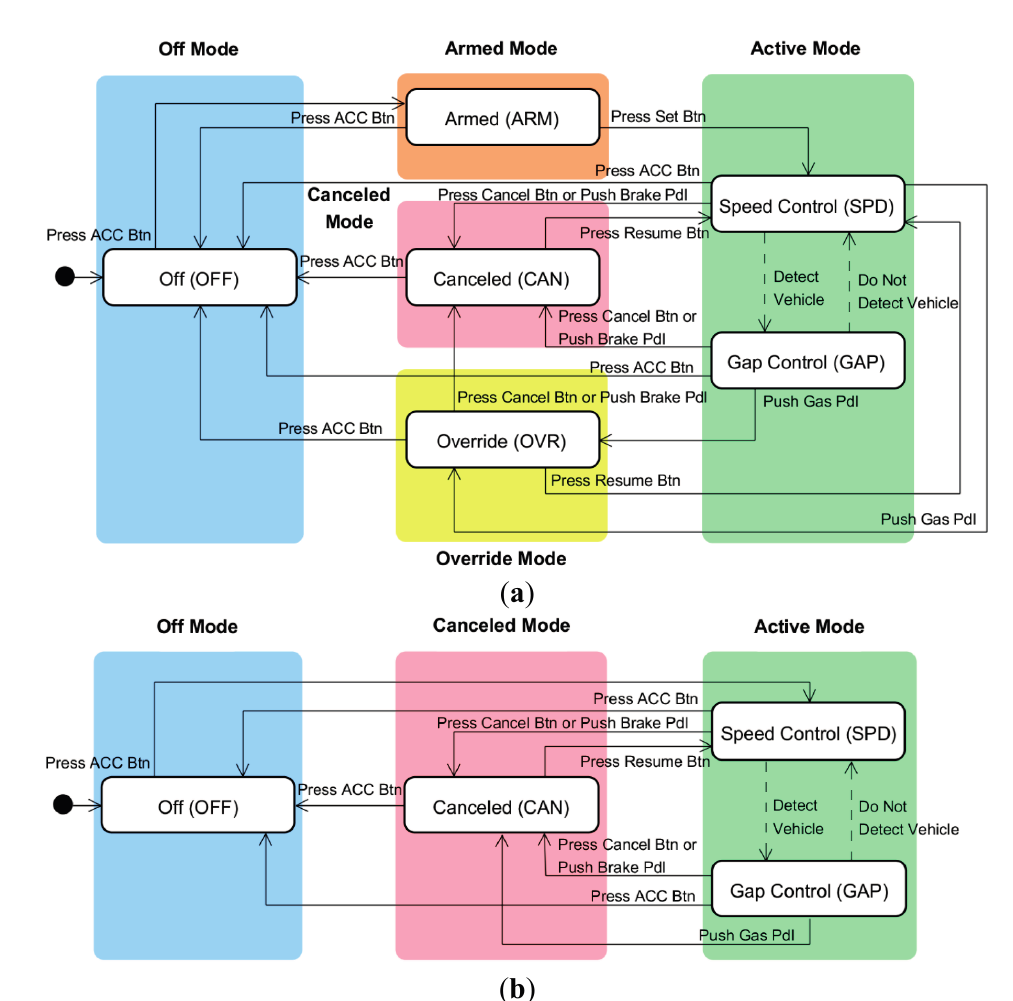
Figure 7. Design of new interface models for the ACC system: ( a ) five-mode interface model; and ( b ) three-mode interface